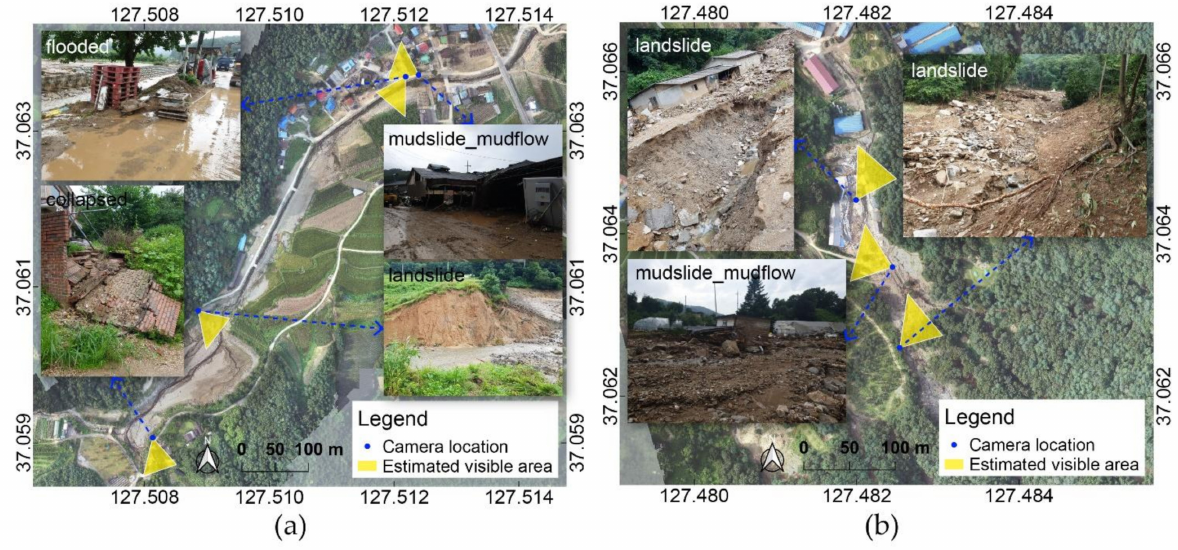
Figure 11. Example images from results analyzed with 5 August dataset: ( a ) Yul and ( b ) Iljuk. The coordinates refer to WGS84 (EPSG: